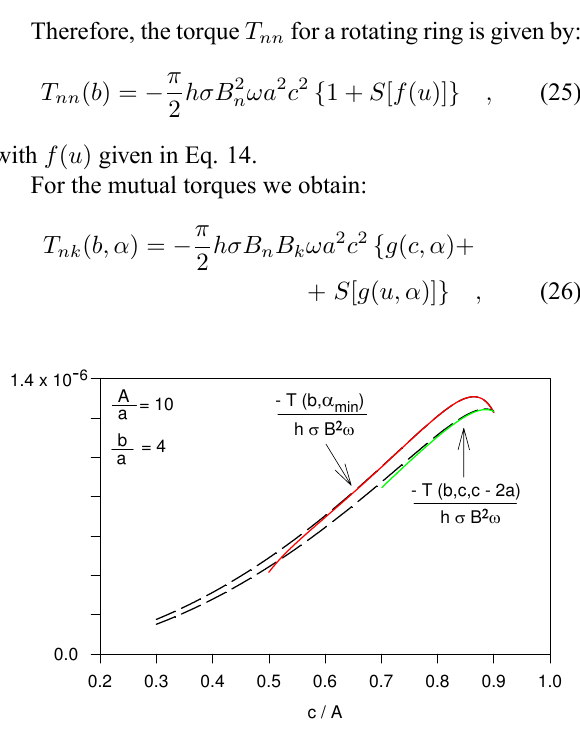
Figure 5: Ratios − T ( b, α min )) /hσB n B k ω and − T ( b, c, c − 2 a )) /hσB n B k ω for the total torques per pole as functions of the ratio c/A for A/a = 10 and b/a = 4 . The two poles touch each other at the azimuthal (red curve) and radial (green curve) arrangements. The dashed black curves correspond to the case b = 0 , as shown in Fig.